Question: Briefly state, in one sentence, what is plotted here.
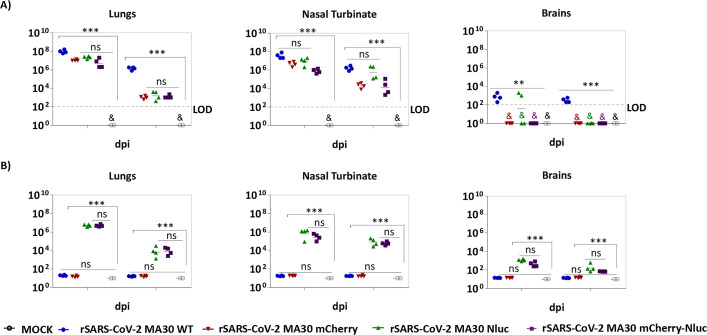
Answer: Viral titers and Nluc activity in tissue homogenates of C57BL/6 mice infected with reporter-expressing rSARS-CoV-2 MA30: Viral titers ( A ) and Nluc activity ( B ) in the lung (left), nasal turbinate (middle), and brain (right) tissue homogenates of 22-week-old C57BL/6 mice mock-infected or infected i.n. with 10 5 PFU/mouse of rSARS-CoV-2 MA30 WT, rSARS-CoV-2 MA30 mCherry, rSARS-CoV-2 MA30 Nluc, and rSARS-CoV-2 MA30 mCherry-Nluc at 2 ( n = 4/group) and 4 ( n = 4/group) dpi were determined by standard plaque assay and microplate reader, respectively. The results are the mean values and SD. LOD, limit of detection. **P < 0.01; *** P < 0.001; ns, not significant; (&) nd, not detected.